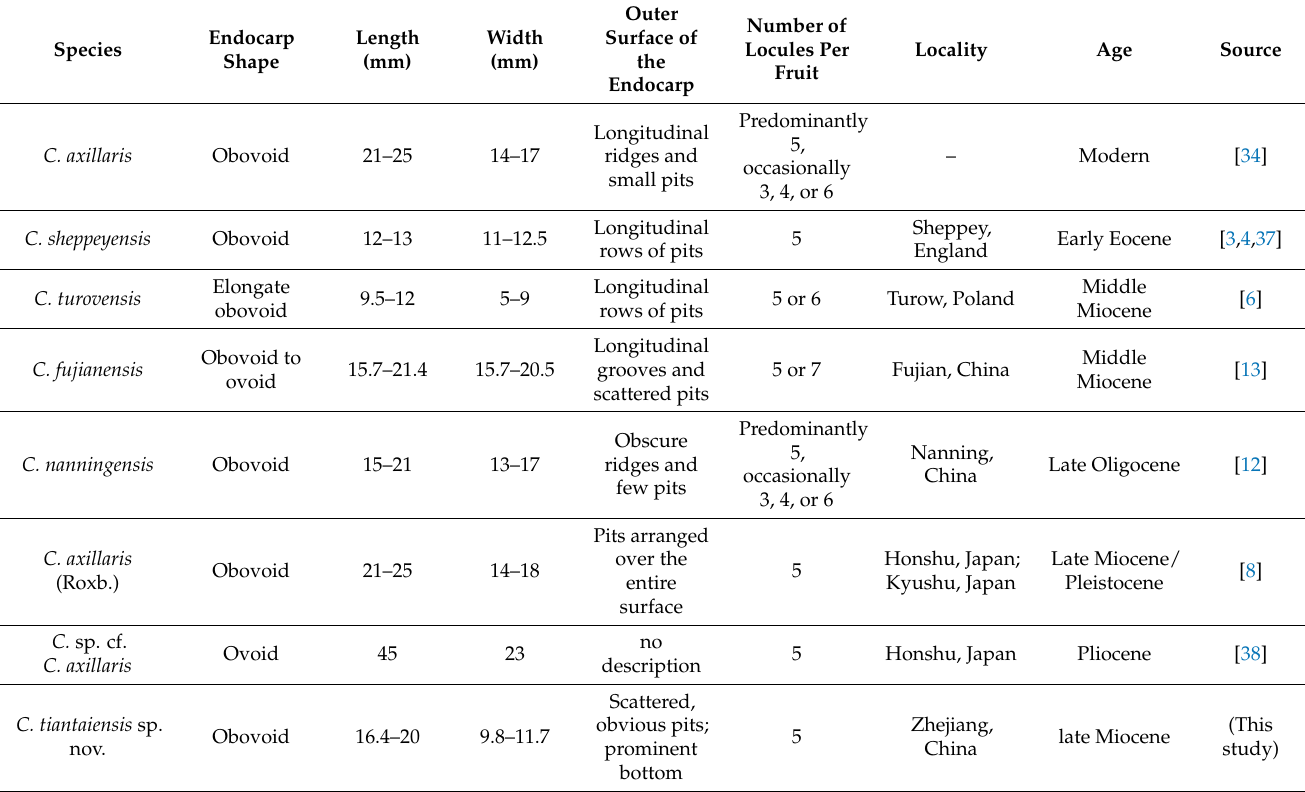
Table 1. Comparisons of Zhejiang Choerospondias endocarps with extant and other fossil